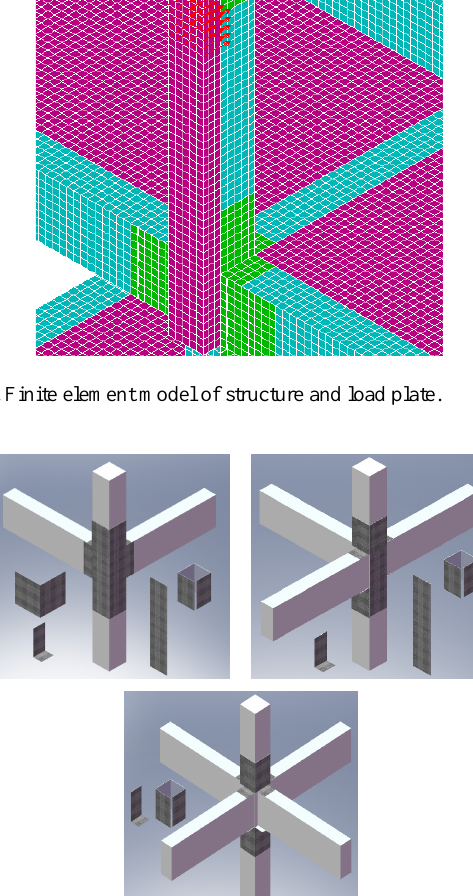
Figure 6. FRP Application Details of Corner, Side and Middle Joints Fig. 6. FRP application details of corner, side and middle